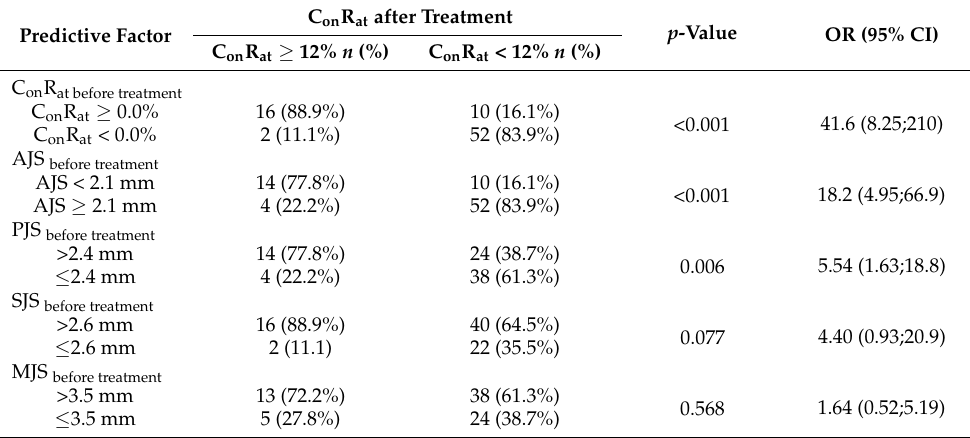
Table 12. Predictive factors for obtaining anterior condylar position after the end of the treatment. Predictive Factor